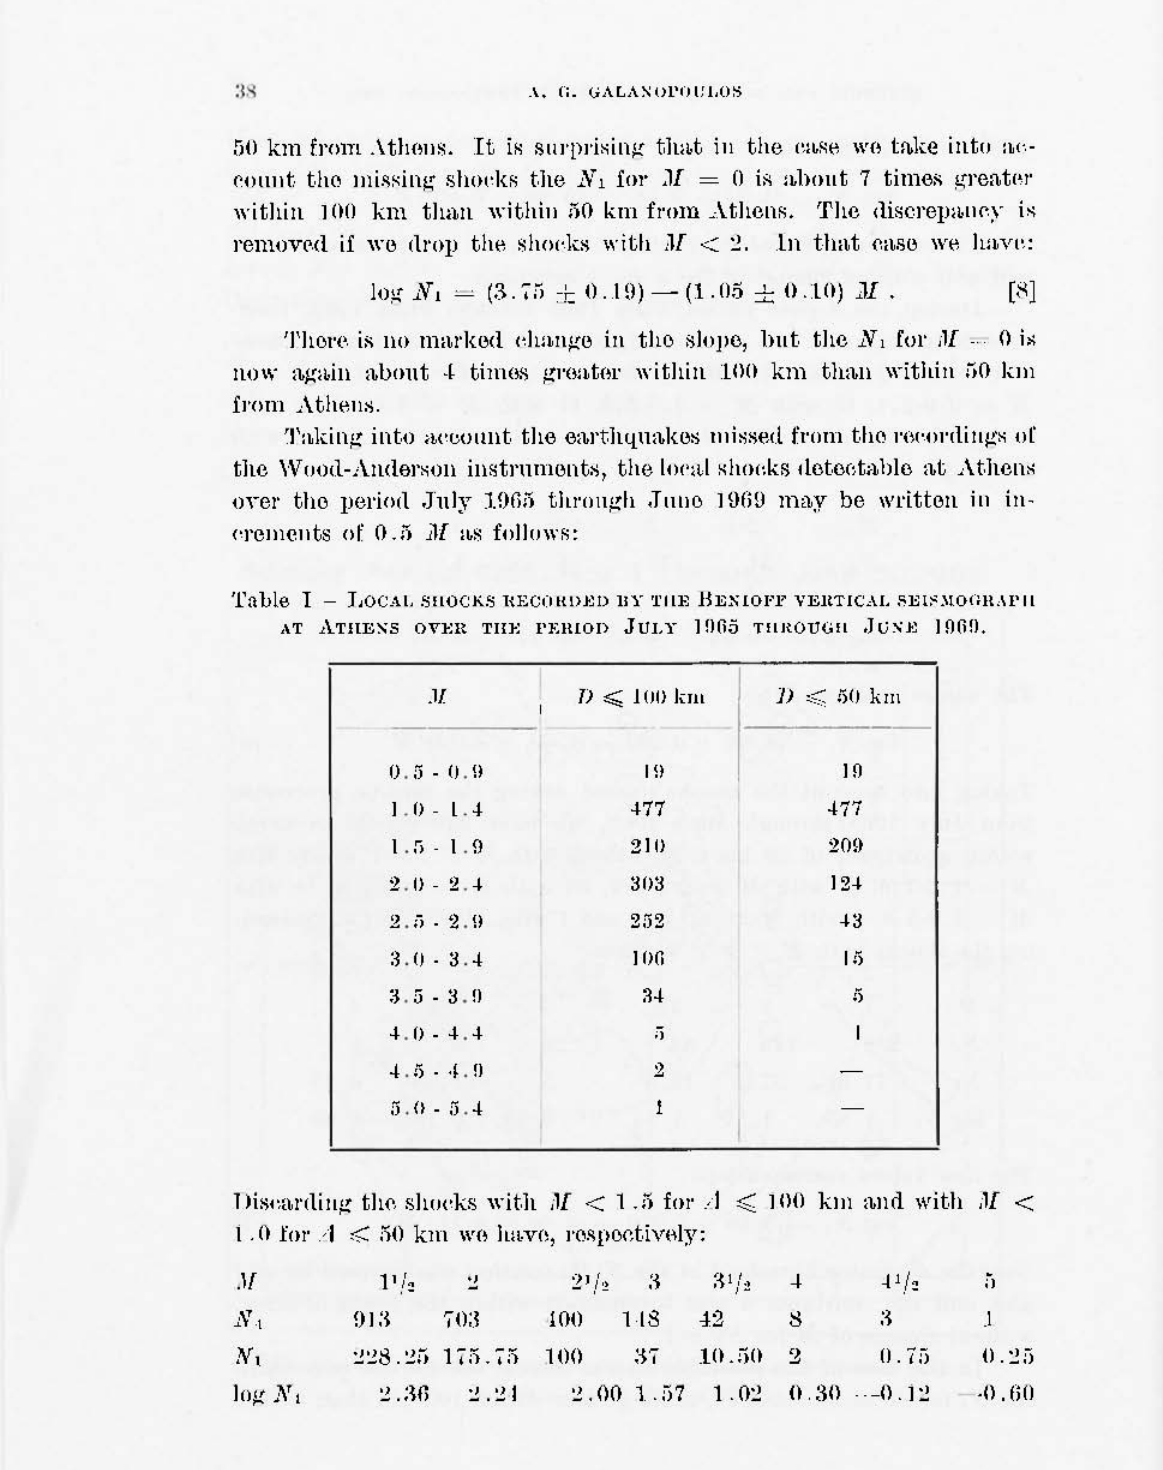
Table 1 - Loc,\l. S!lOCIi.S HEC(lHIHm II)" 'l"([}, HE};lOFl' VERTICAL